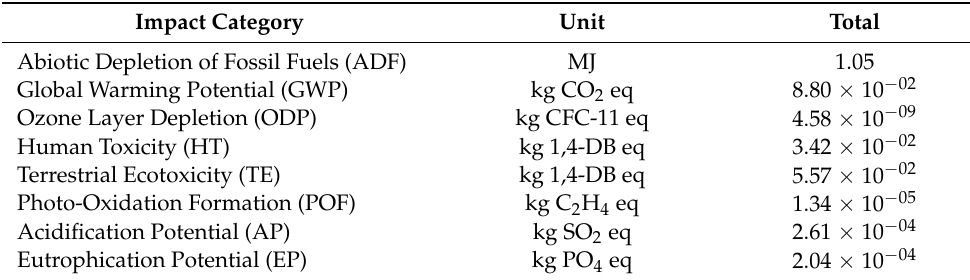
Table 5. Environmental impact categories evaluated a .